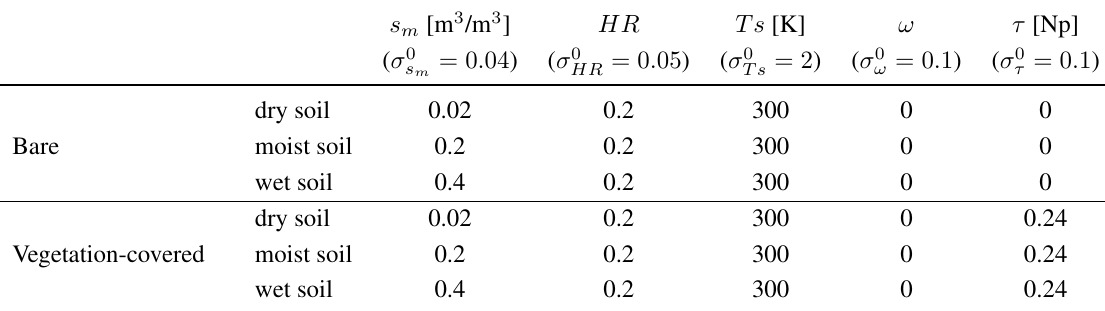
Table 1. Selected original values of soil moisture ( s soil temperature ( T ), vegetation albedo ( ! ) and vegetation opacity ( (cid:28) ) for the s six master scenarios. (cid:27) 0 is the nominal uncertainty of parameter p p i